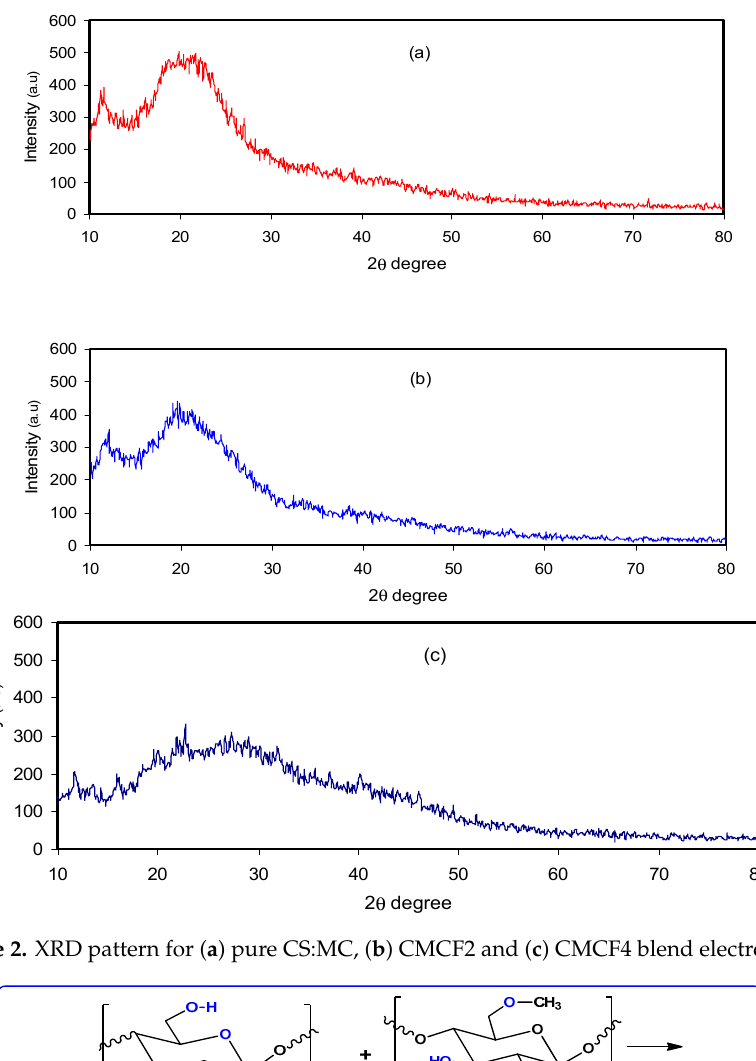
Figure 2. XRD pattern for ( a ) pure CS:MC, ( b ) CMCF2 and ( c ) CMCF4 blend electrolytes.